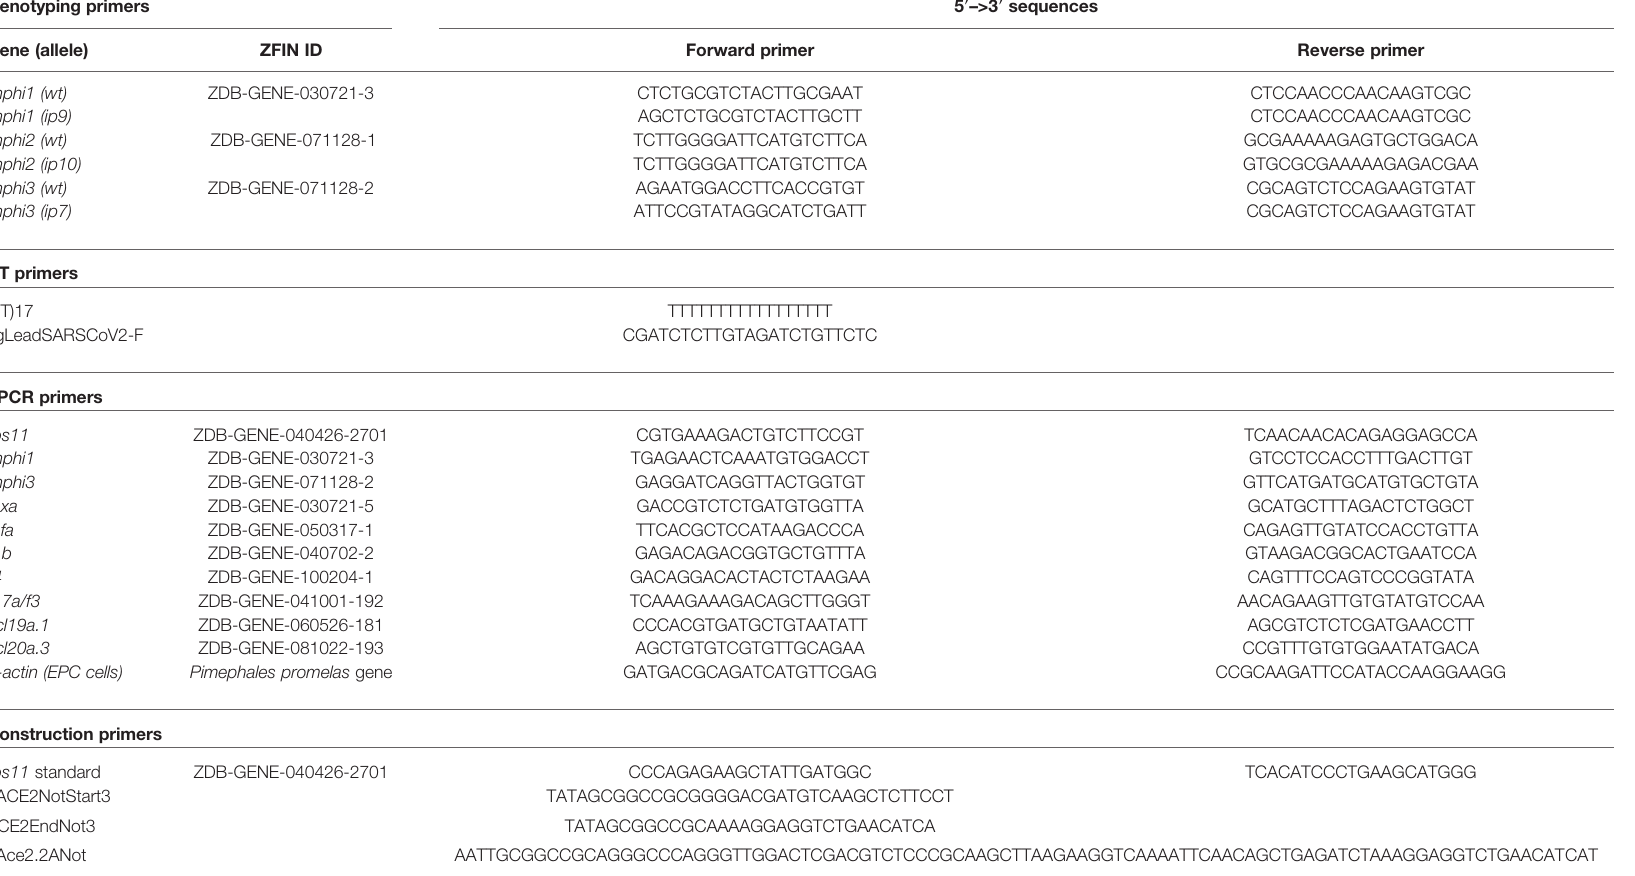
TABLE 2 | Primers used in this